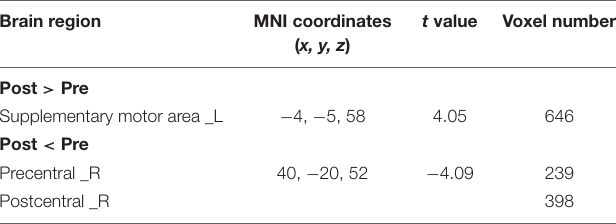
TABLE 3 | Brain regions showing significantly different CBF between real and sham rTMS posttreatment. Brain region